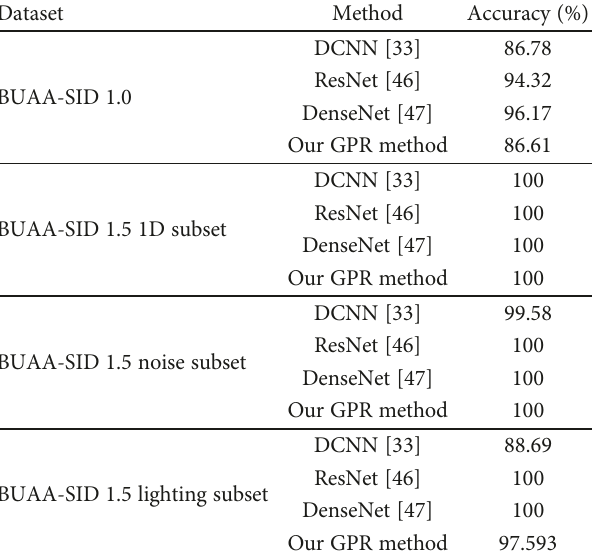
Table 4: Satellite recognition results and comparison with deep learning